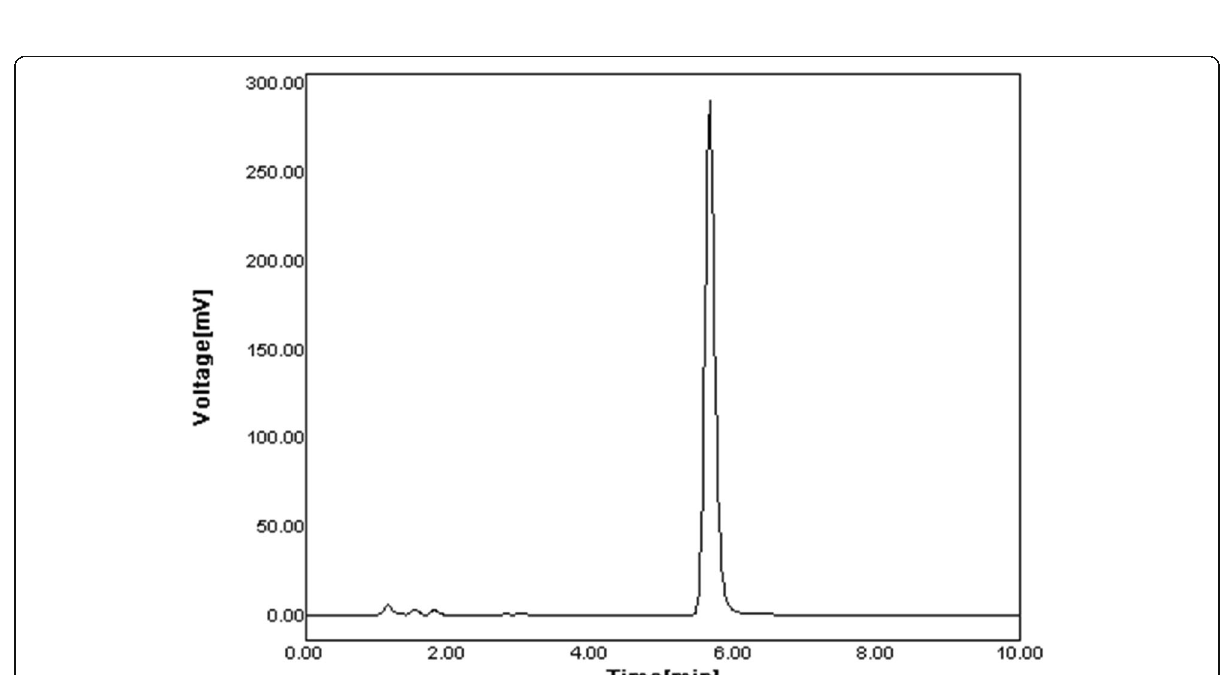
Fig. 3 Chromatogram of clotrimazole (20 μ